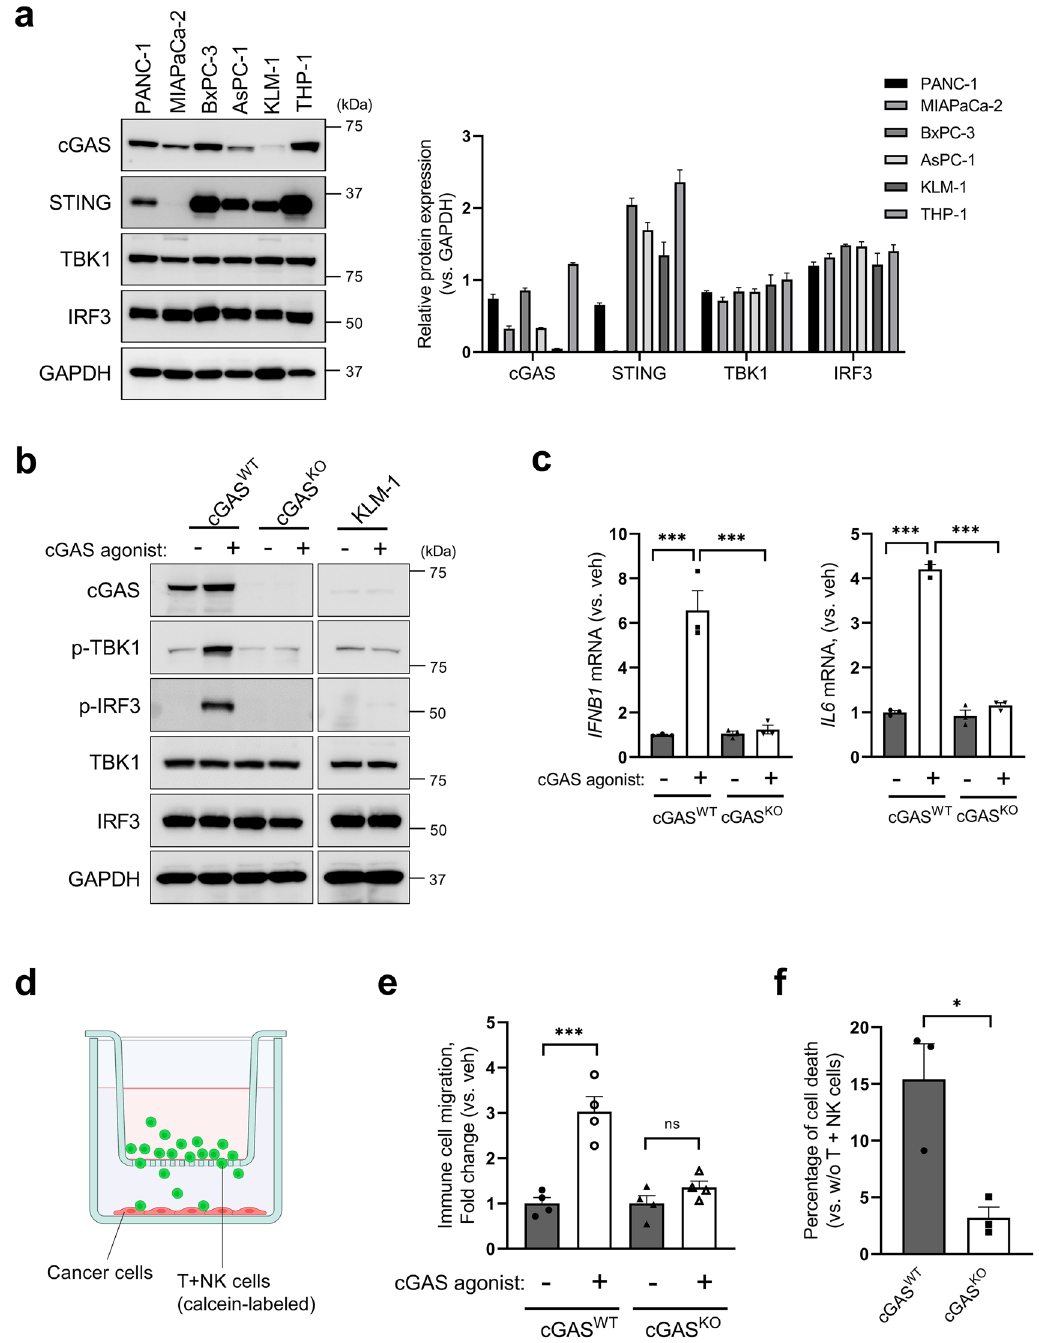
Figure 3. Knock-out of cGAS attenuates cytokine expressions and subsequent immune cell migrations toward cancer cells. ( a ) Immunoblot (left panel) and densitometric (right panel) analysis of cGAS-STING signaling associated proteins. THP-1 human acute monocytic leukemia cells were employed as a positive control for cGAS-STING signaling. Densitometric data for each protein expression was normalized to GAPDH. ( b ) cGAS- STING signaling activation by cGAS agonist, G3-YSD. cGAS WT BxPC-3, cGAS KO BxPC-3, and THP-1 cells were treated with or without G3-YSD (1 µg/mL) for 5 h by lipofection. ( c ) IFNB1 and IL6 mRNA levels were assessed by RT-qPCR. Cells were treated with or without G3-YSD (1 µg/mL) for 24 h. ( d ) A scheme of transwell chamber for an immuno-cancer cells coculture, depicted using BioRender. ( e ) Immune cell migration assay in BxPC-3 cells with or without cGAS agonist. ( f ) Cell death rate of cGAS WT BxPC-3 and cGAS KO BxPC-3 cells caused by immune cell coculturing. The bar graphs represent mean ± standard error of the mean (SEM) for at least three independent experiments. * p < 0.1, *** p < 0.001. ns non-significant. Statistical significance was determined using the 2-tailed t test or one-way analysis of variance (ANOVA) followed by Tukey’s test. This figure was created using GraphPad Prism 9.3.0 (https:// www. graph pad. com/ scien tific- softw are/